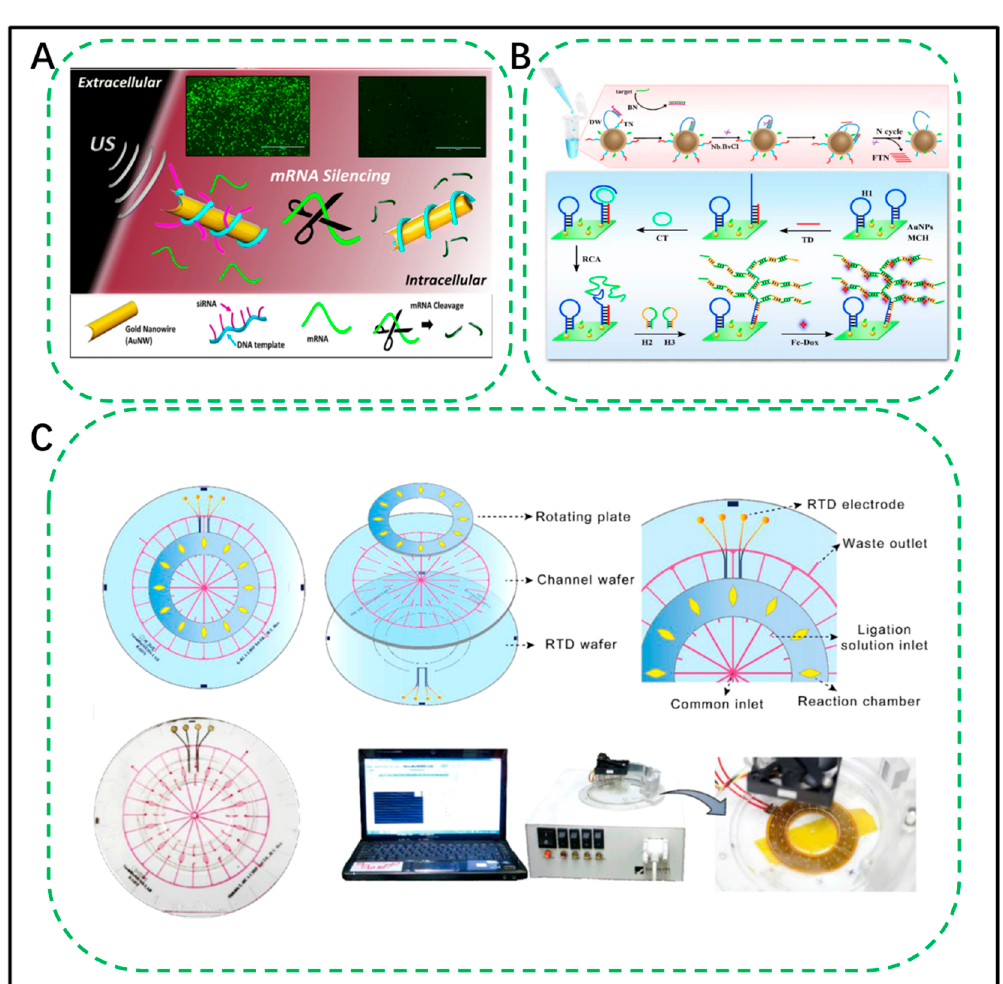
Figure 7. Emerging nanotechnology for RCA assay [141,143,145]. ( A ) Schematic of the nanomotor-based gene silencing approach; ( B ) Schematic representation of the multiple sensitizing electrochemical biosensor for the detection of E. coli O157:H7; ( C ) a novel rotary microfluidic device which can perform multiplex single nucleotide polymorphism typing on the mutation sites of TP53 genes.